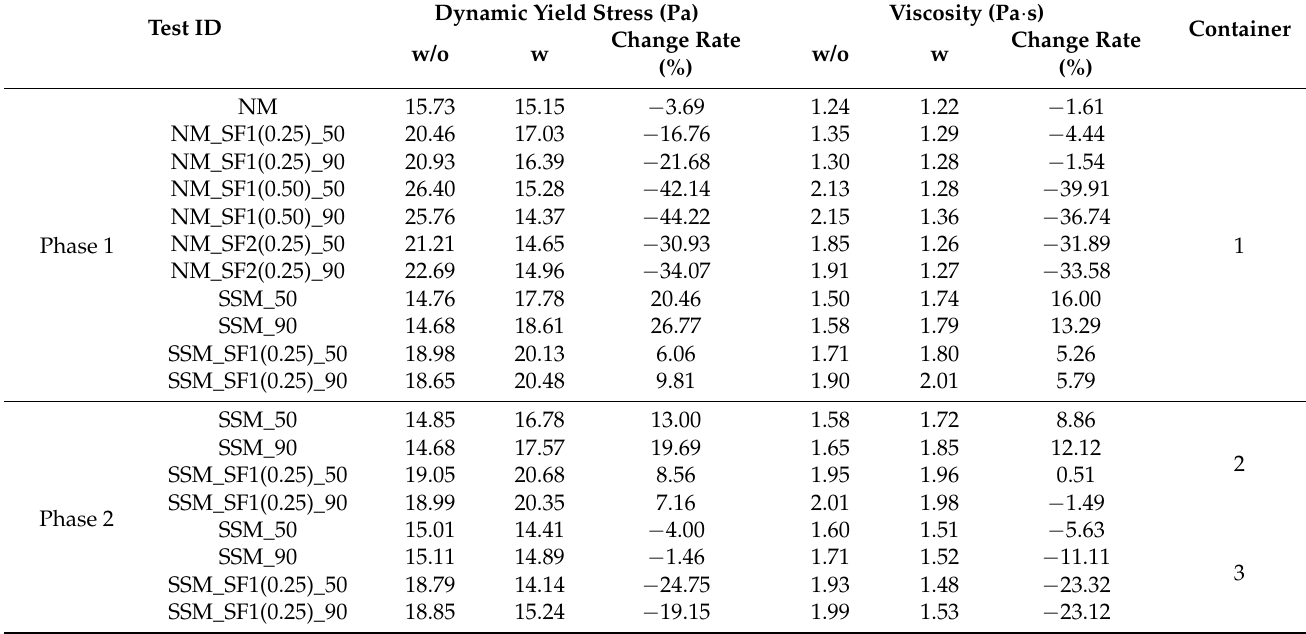
Table 7. Test result